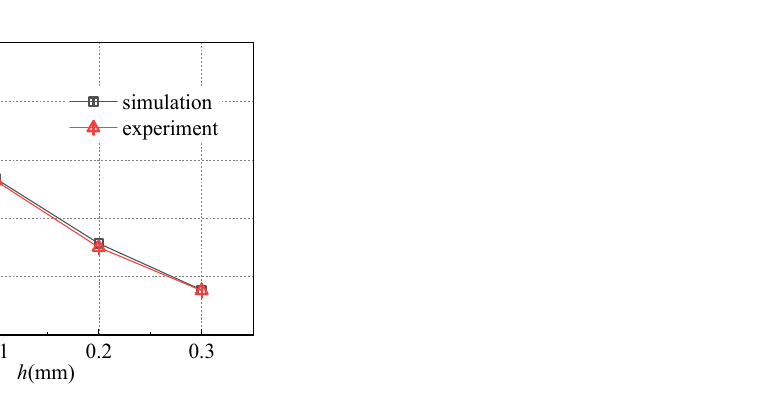
( d ) h = 0.3 mm Figure 14. The influence trend chart of five optimization variables on static electromagnetic force. The optimal structural design factors combination for the maximum static electro- magnetic force is S m 2 (3) δ (1) α (3) hd (2) hl (1). Meanwhile, the optimized HFSV prototype